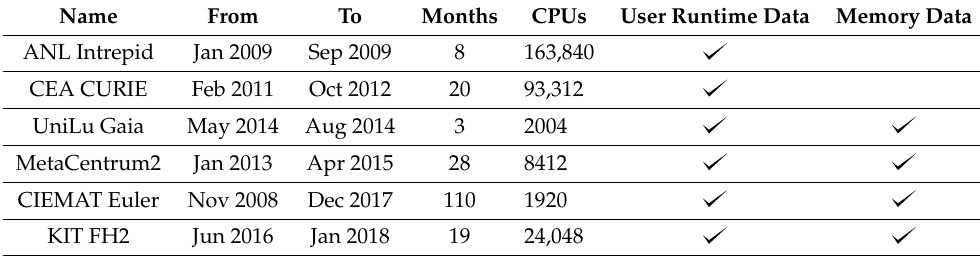
Table 6. Datasets chosen for analysis from the Parallel Workloads Log.